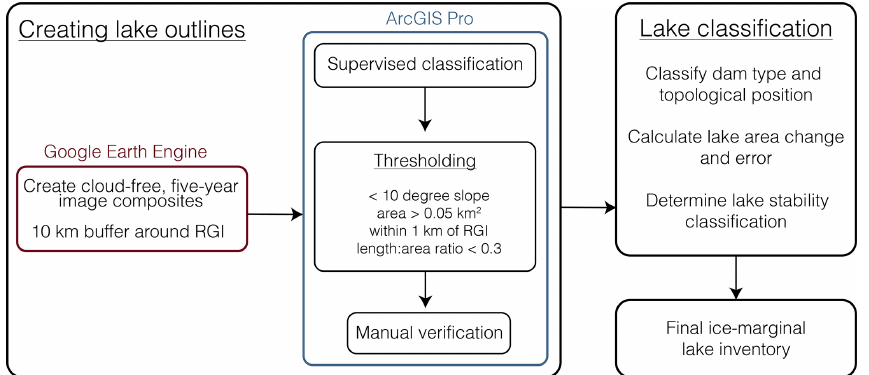
Figure 2. General workflow for creating the ice-marginal lake inventory for the time periods 1984–1988, 1997–2001, 2007–2011, and 2016– 2019. Table 2. Count (area, km 2 ) of glacial lakes by dam type and location between 1984 and 2019, as well as median area (km 2 ), range of areas (km 2 ), and median area change (km 2 ) for all lakes. Median area change for lakes with detectable change (km 2 ) is in the